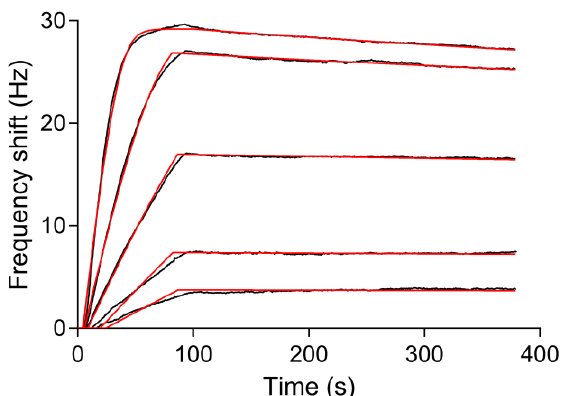
Figure 9. Reuse of the sensor chip for kinetic evaluation of the interactions between myoglobin and anti-myoglobin 7005 antibody. Myoglobin at 0.25, 0.5, 1, 2 and 4 μg/mL (14.7, 29.4, 58.8, 118 and 235 nM) was injected over the sensor surface and the responses were recorded (black lines). Theoretical 1:1 fit using the Evaluation software (Attana) was overlaid (red lines).